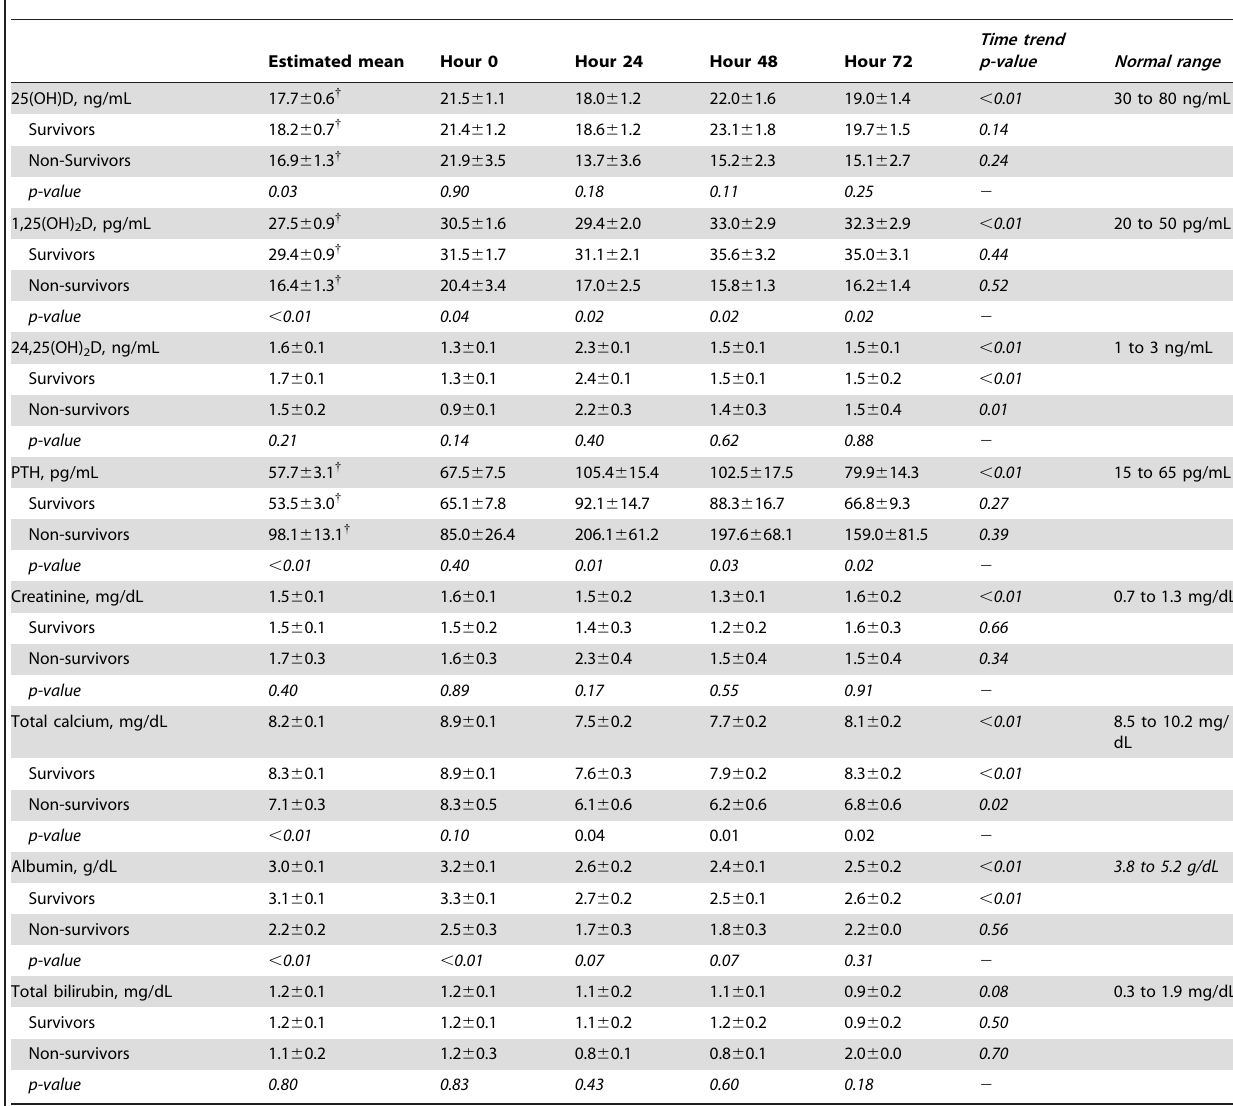
Table 2. Vitamin D status and related variables measured over 72 hours that may be associated with 30-day